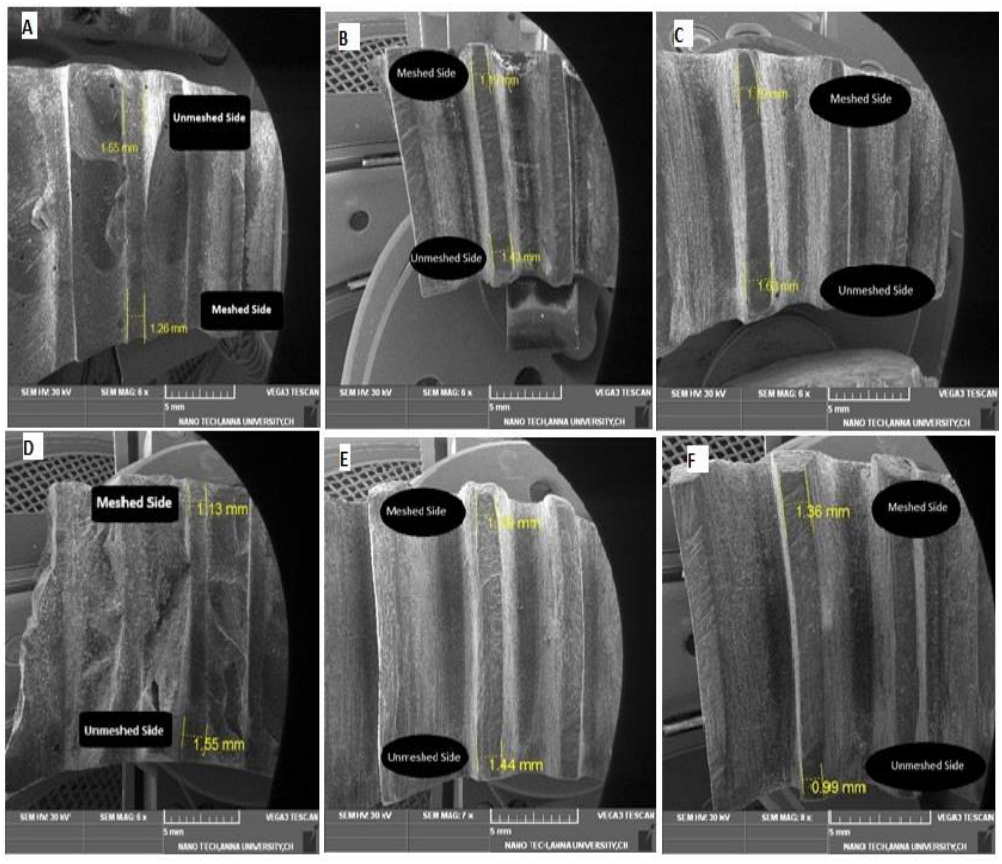
Figure 7. Reduction in tooth thickness. ( A ) GFRPG-20. ( B ) FFRPG-20. ( C ) SFRPG-20. ( D ) GFRPG-15. ( E ) FFRPG-15. ( F ) SFRPG-15.